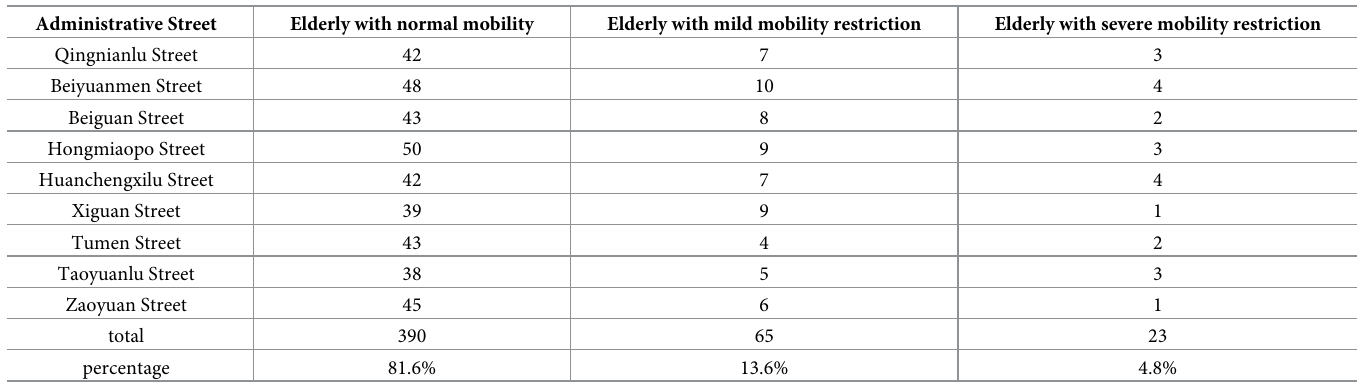
Table 2. Questionnaire of the elderly’s mobility in Lianhu